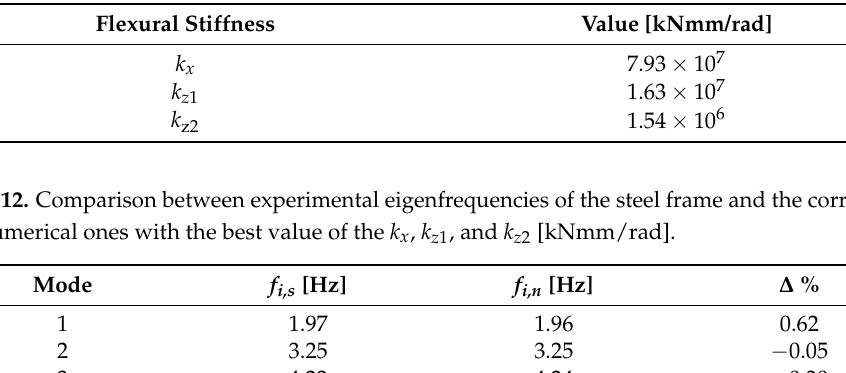
Table 11. Values of k x , k z 1 , and k z 2 that minimize the error function.